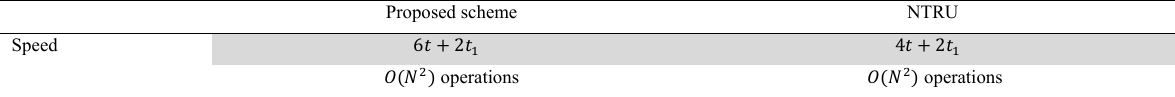
Proposed scheme NTRU